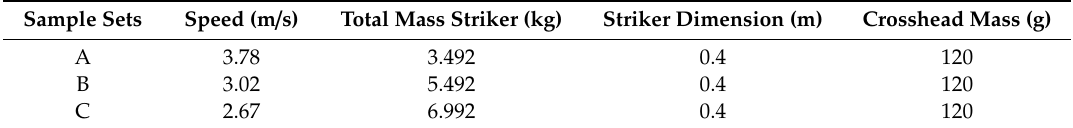
Table 2. Speed of the striker related to the total mass.